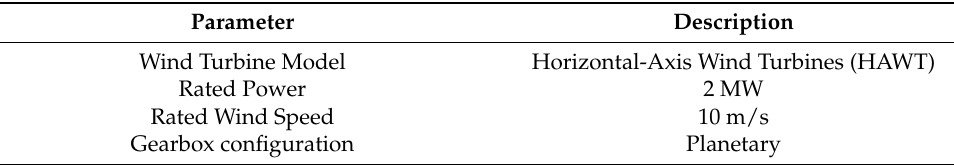
Table 1. Wind turbine